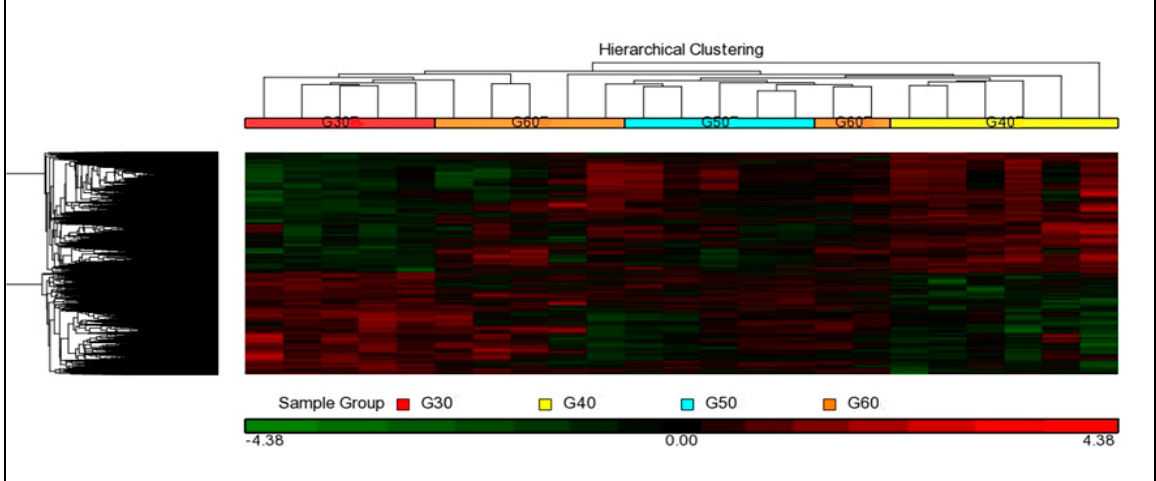
Figure 4. Supervised hierarchical cluster analysis of gene expression in normal aging age 30 (red), age 40 (yellow), age 50 (blue), and age 60 (orange).